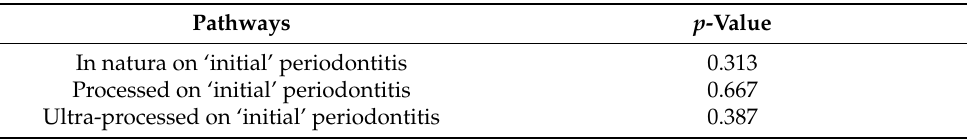
Table A2. Standardized effects of the interaction between ‘initial’ periodontitis and halitosis on food consumption among adults enrolled in the 1982 Pelotas birth